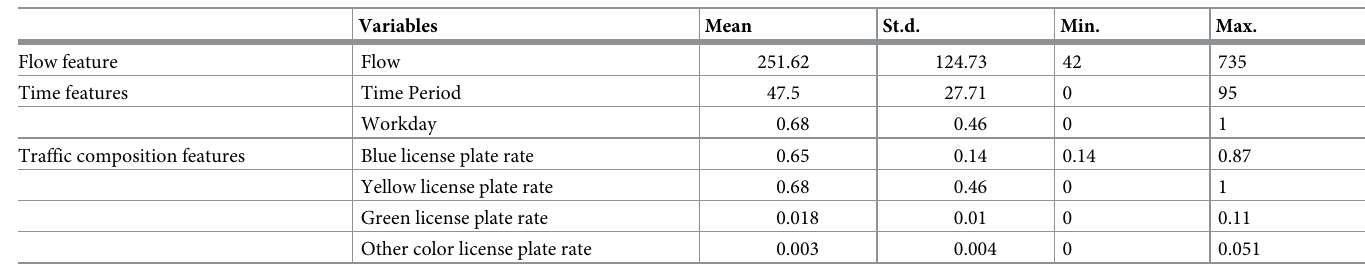
Table 3. Variable description.